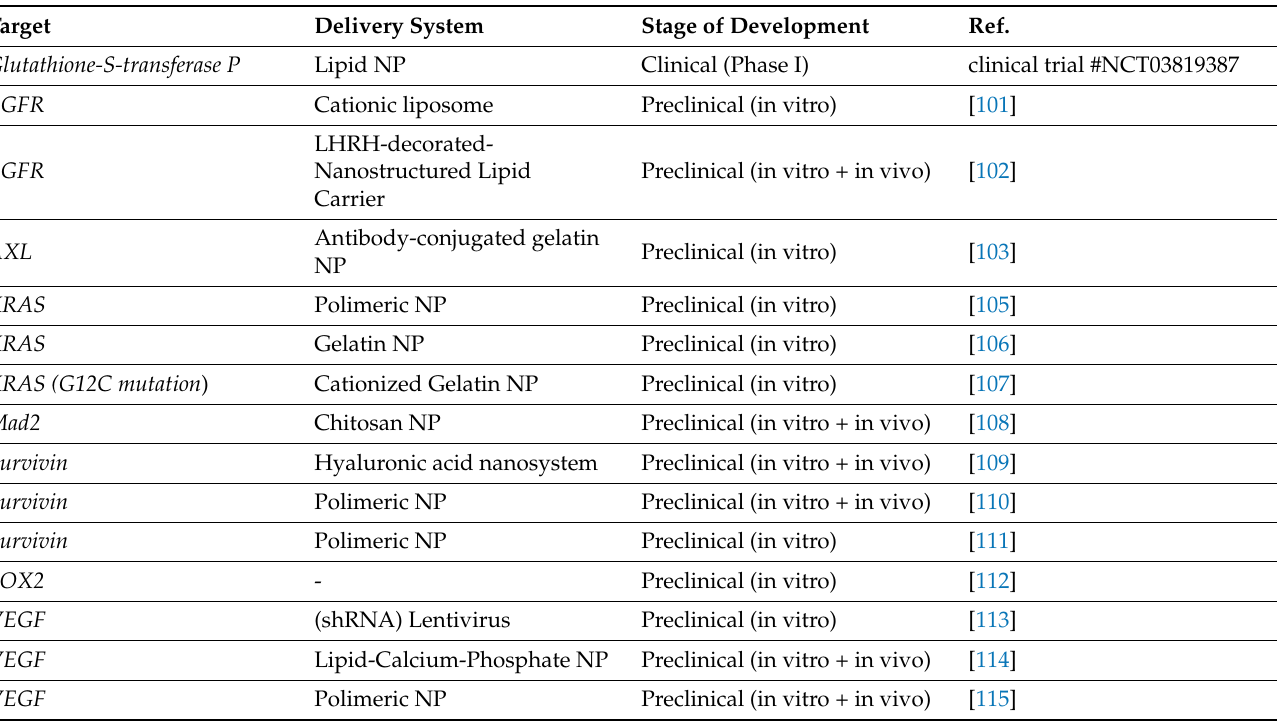
Table 3. Main siRNA-based therapeutics applied to NSCLC